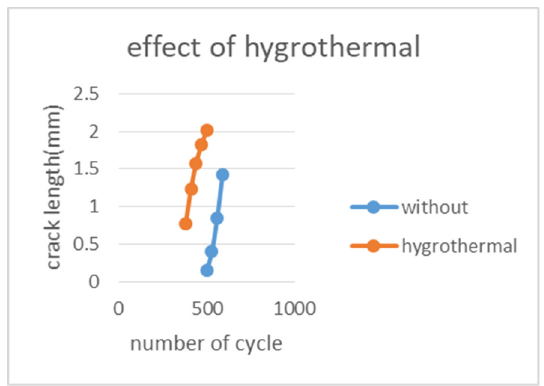
Fig.11. Effect of hygrothermal on crack growth for 50cm